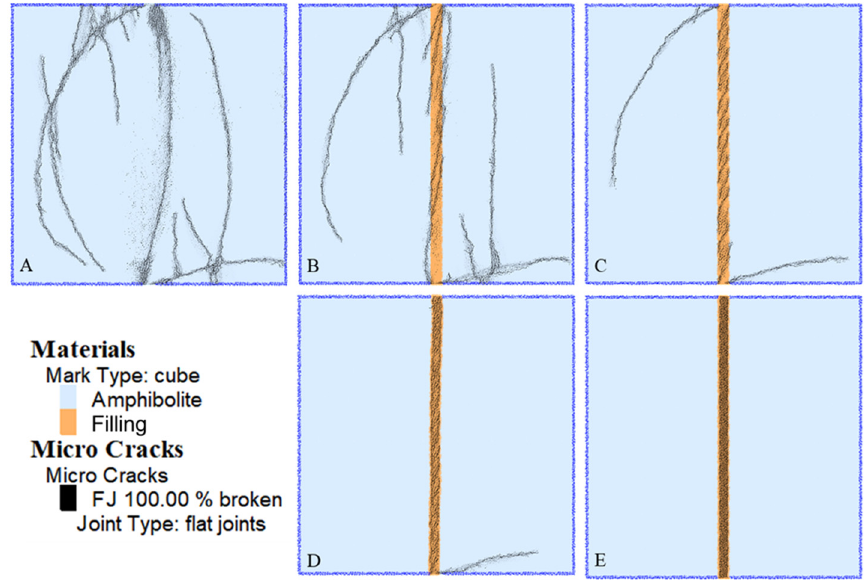
Figure 18. Failure mechanisms in shear specimens with ( A ) no infill, ( B ) quartz infill, ( C ) calcite infill, ( D ) mudstone infill, and ( E ) clay infill.